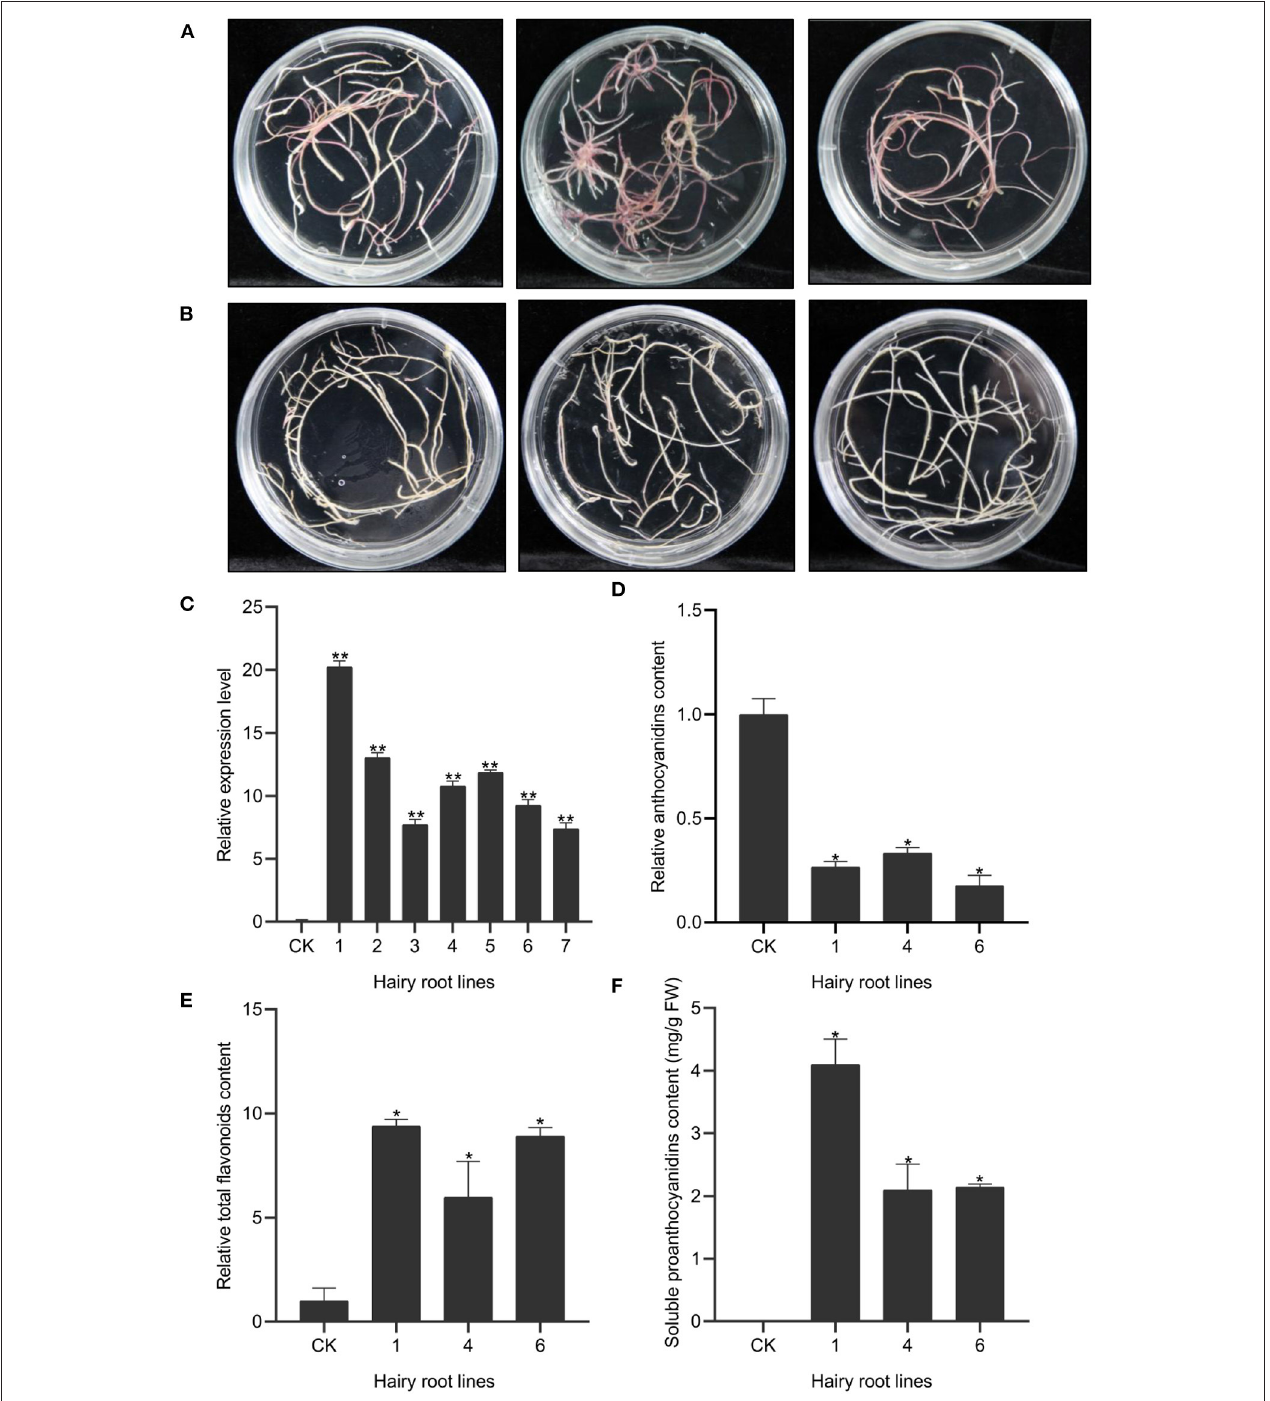
FIGURE 6 | Over-expression of OvMYBPA2 in alfalfa hairy roots. (A) Phenotype of control hairy roots grown on B5 medium. (B) Phenotype of OvMYBPA2 -over-expressing hairy roots grown on B5 medium. (C) Relative expression levels of OvMYBPA2 in transgenic hairy roots and control hairy roots (CK). (D) Proanthocyanidins content in different transgenic hairy root lines. (E,F) Relative content of anthocyanidin (E) and flavonoids (F) . Error bar depicts the standard error of mean ± SD of three biological replicates. Significance of differences are indicated with one asterisk ( p < 0.05) and two asterisk ( p < 0.01).